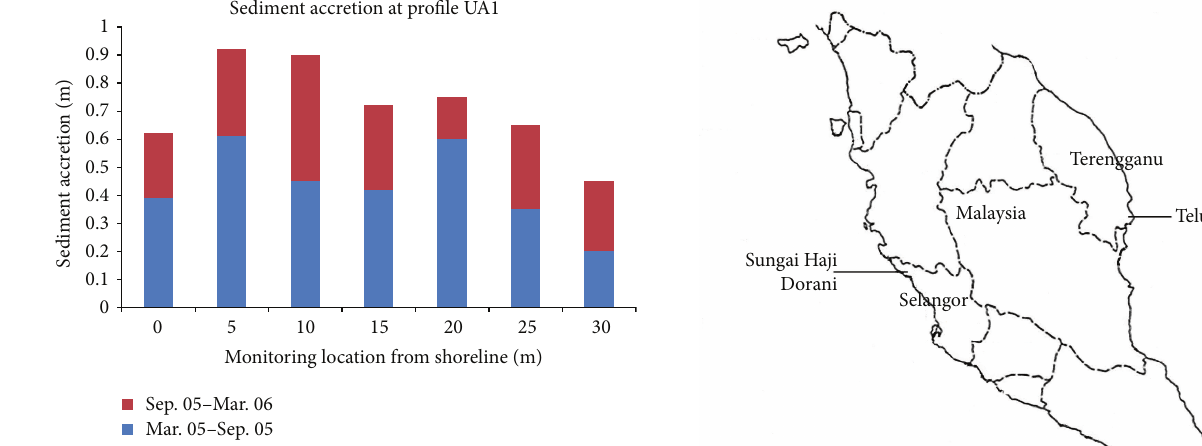
Figure 2: Sediment accretion at profile UA1, Project Yucatan, Mexico (adapted from ´Alvarez et al., 2006).